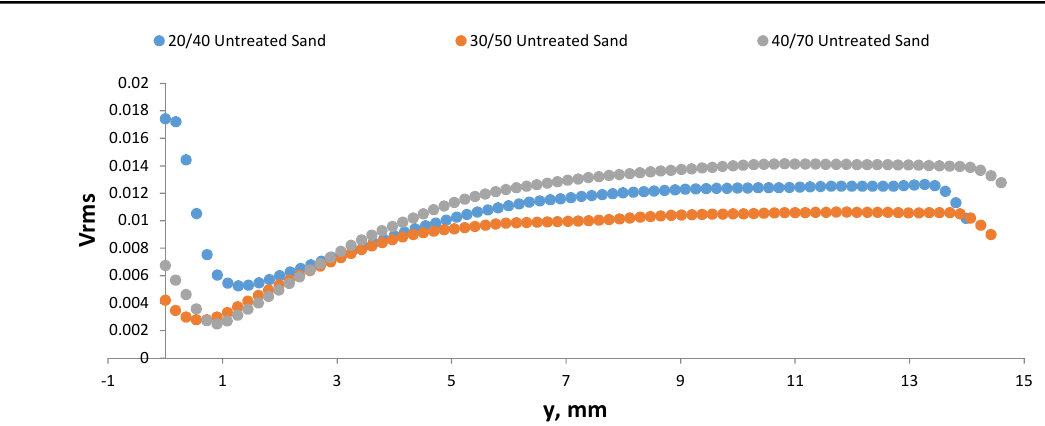
Figure 10. The radial turbulence intensity profile for the flow of polymer fluid over the untreated sand bed at the subcritical velocity of 0.25 m/s.